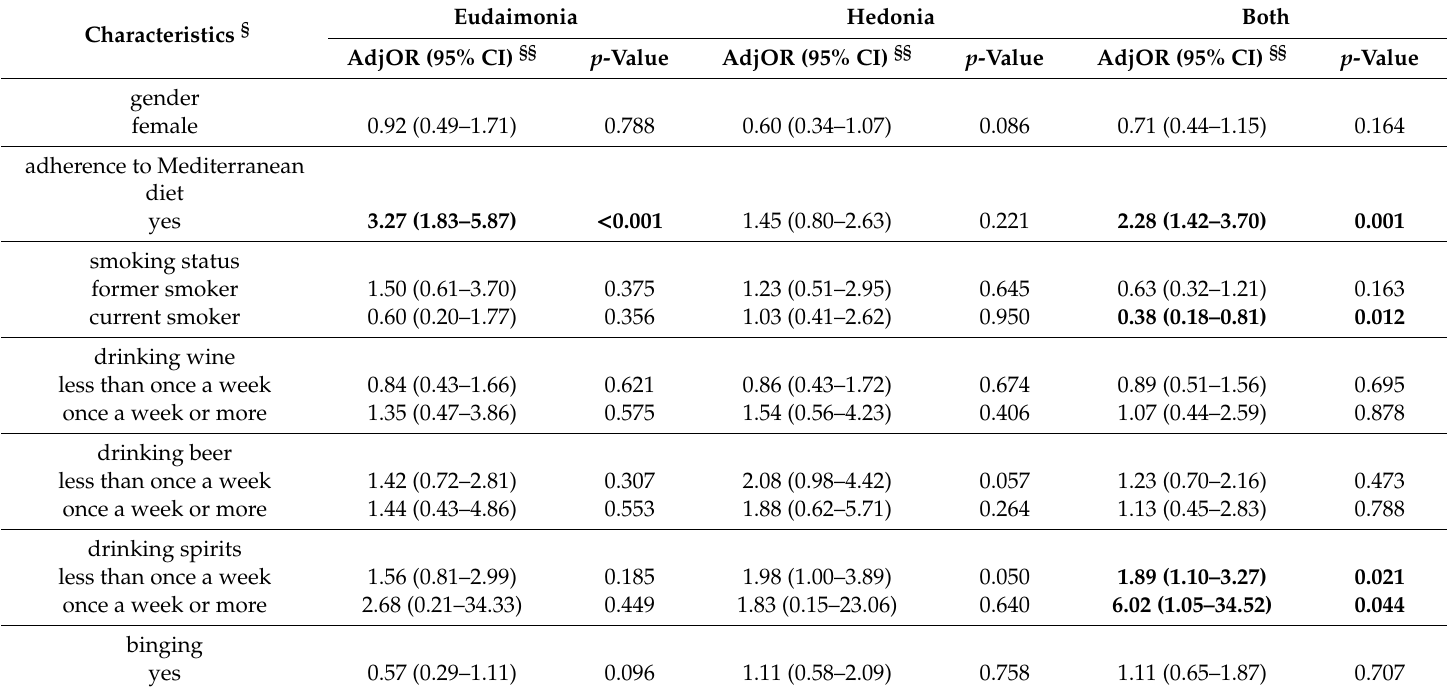
Table 4. Multivariable analysis of well–being by modifiable behavioral characteristics in a sample of 508 undergraduates of University of Palermo. Characteristics